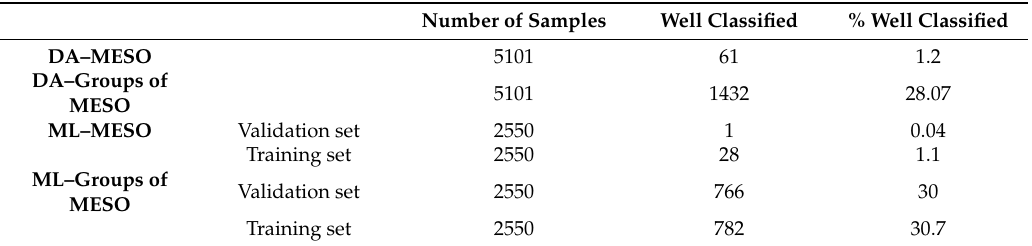
Table 3. Results of discriminant analysis (DA) and machine learning (ML) performed on MESO and groups of